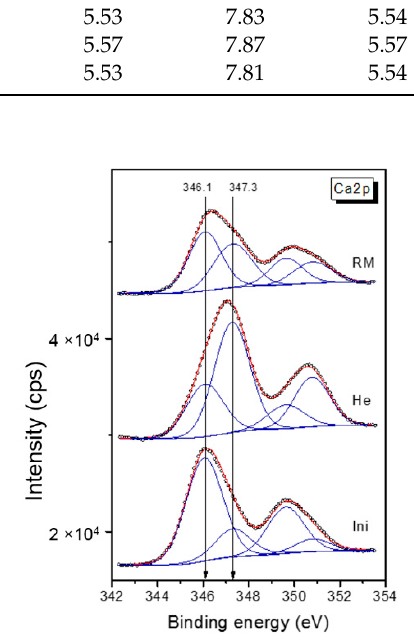
Table 4. The ratio of atomic concentrations of the elements presented in the studied samples.